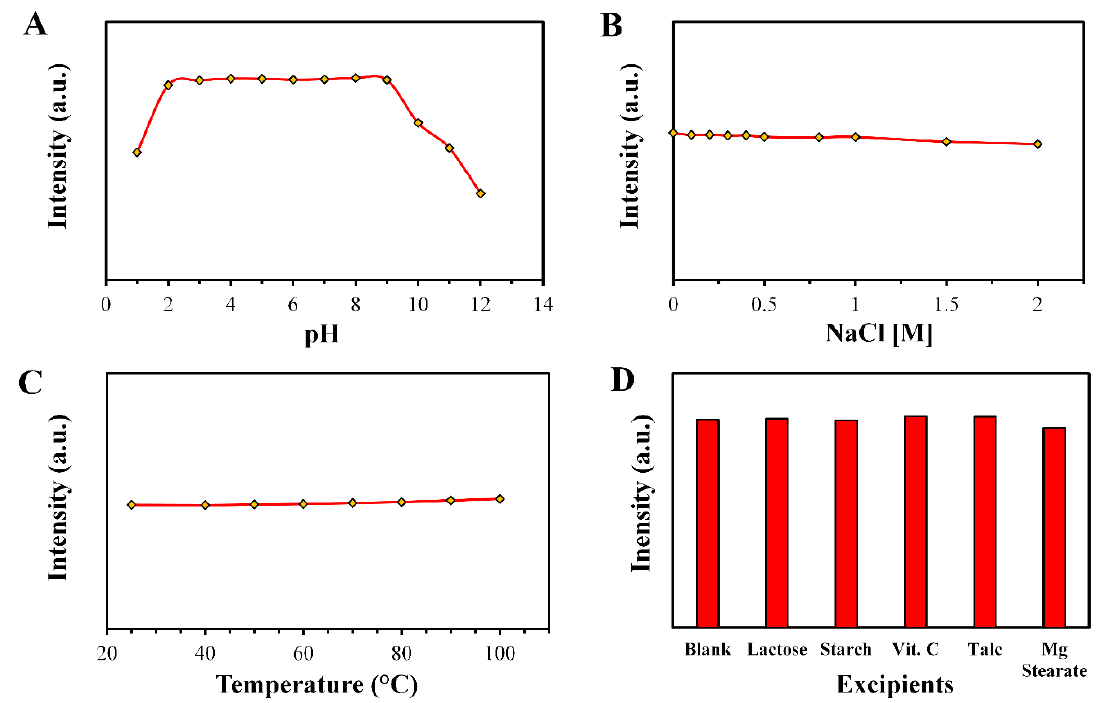
Figure 5. The effect of pH ( A ), ionic strength ( B ), temperature ( C ), and excipients ( D ) on the fluorescence intensity of the CNDs.